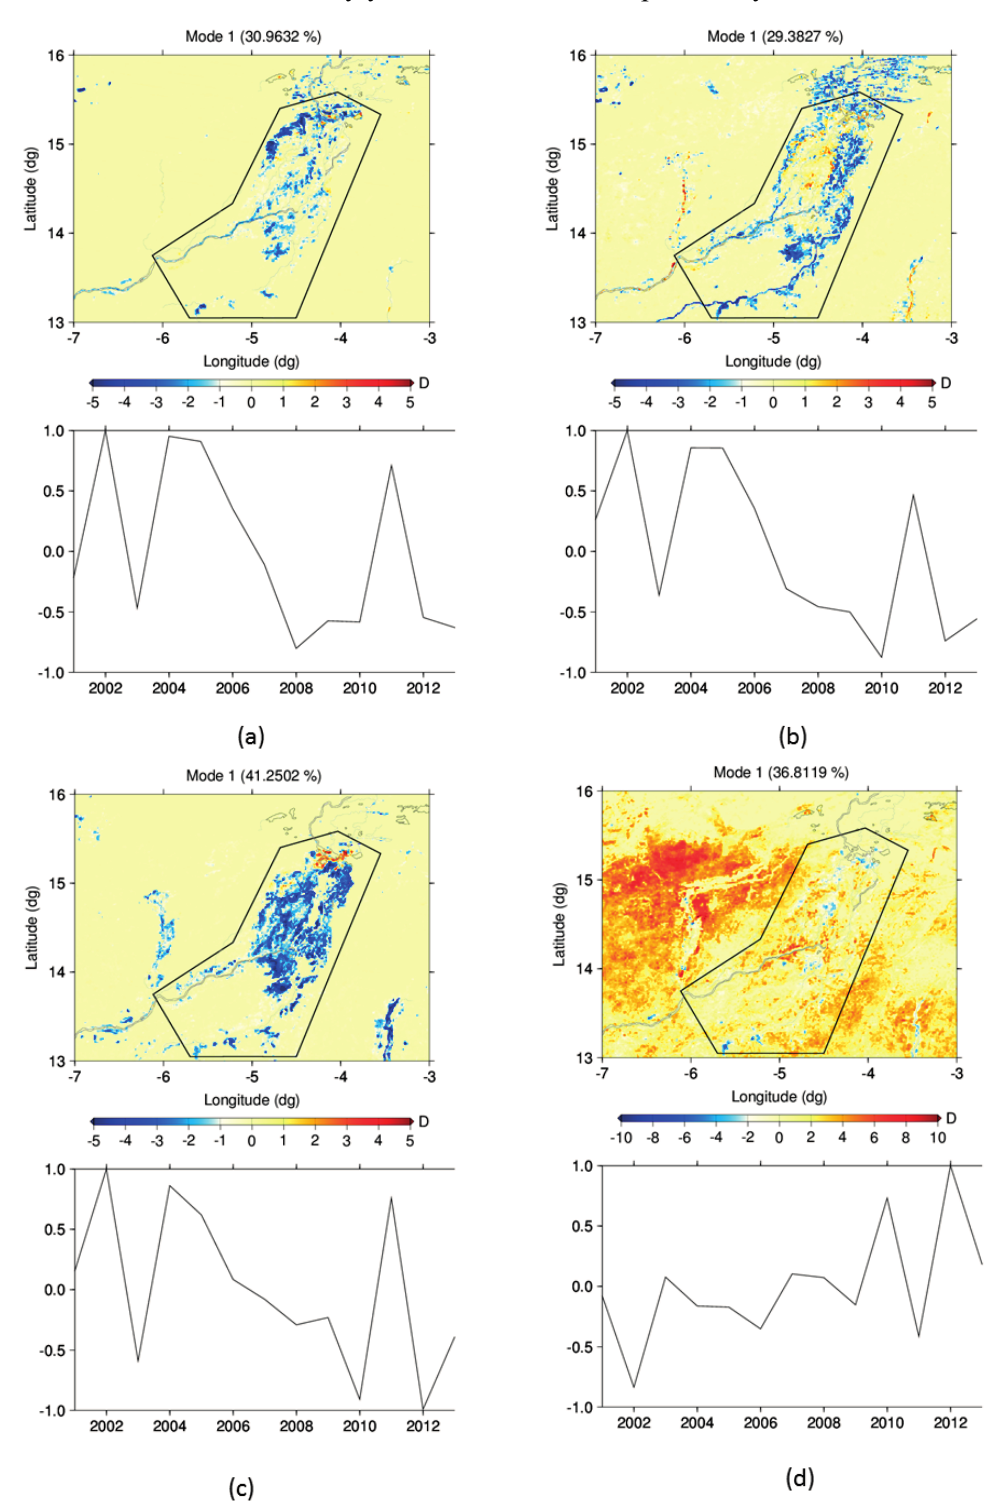
Figure 14. Moderate Resolution Imaging Spectroradiometer Empirical Orthogonal Functions (EOF) mode 1 for ( a ) open water; ( b ) mixture of water and dry land; ( c ) aquatic vegetation and ( d ) vegetation over the Region Of Interest (ROI) (black line’s polygon). Units of Empirical Orthogonal Functions time series are